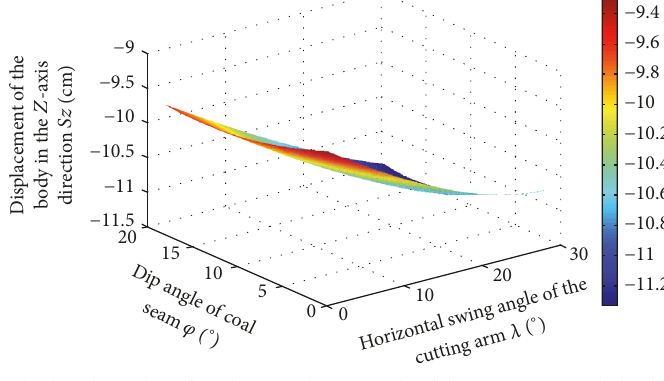
(c) The relationship of 𝑆 𝑍 , horizontal swing angle of the cutting arm, and the dip angle of coal seam Figure 13: The response results of displacement of the body in the 𝑧 -axis direction 𝑆 𝑍